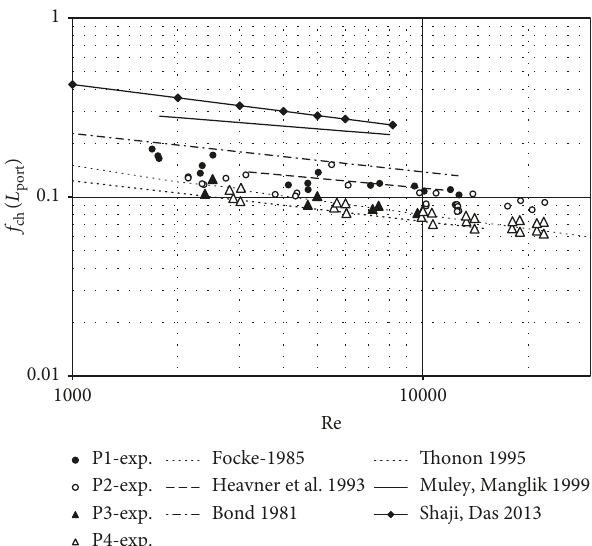
Figure 8: Fanning factor for plates P1–P4 with chevron pattern LL.